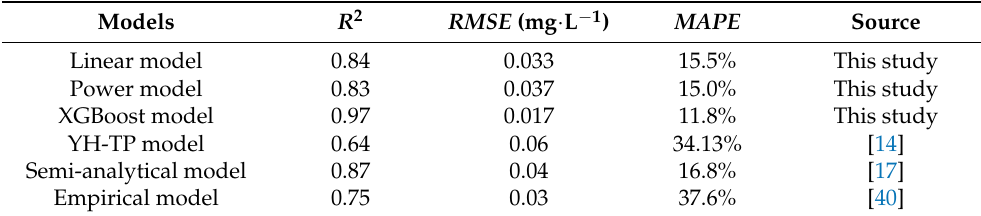
Table 4. The R 2 , RMSE and MAPE of different TP estimation